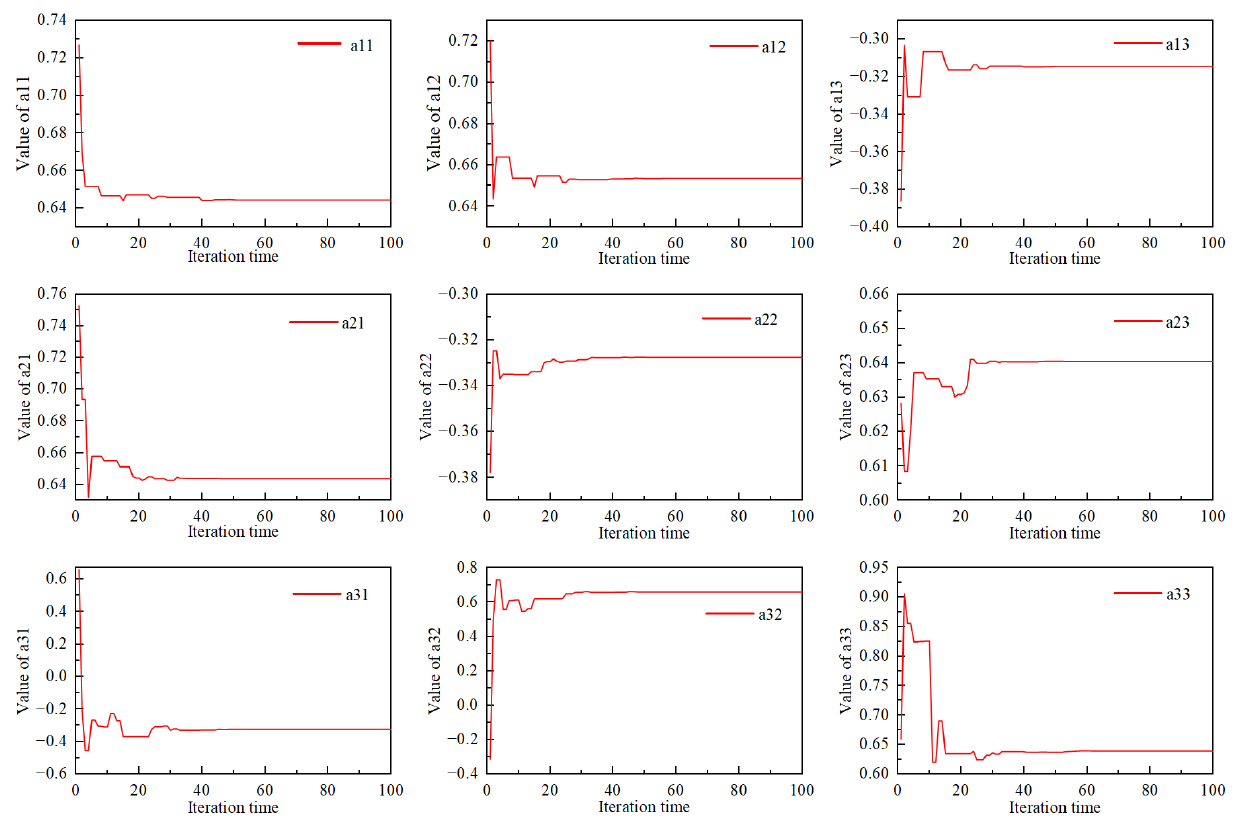
Figure 14. PSO convergence process for searching the matrix parameters. Corresponding to three linear equations shown in Equation (9), the particle swarm optimization algorithm was run three times. The fitness convergence of each solution is illustrated in Figure 15.